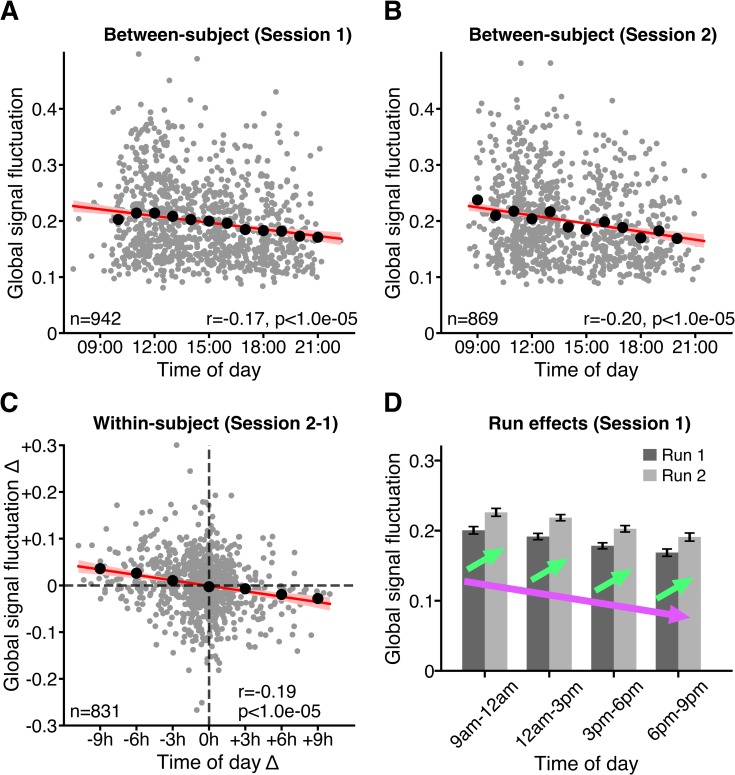
The brain’s GS fluctuation (standard deviation of GS) decreases with time of day.(A) Between-participant variation in GS fluctuation as a function of time of day in session 1. (B) Between-participant variation in GS fluctuation as a function of time of day in session 2. (C) Within-participant variation in GS fluctuation Δ as a function of time of day Δ, where Δ denotes difference between session 2 and session 1. Grey dots denote individual participants. Black dots show mean of GS fluctuation in (A, B) hourly or (C) 3-hourly time windows. Line of best fit (red) was calculated based on data from all participants in each plot. Confidence interval is shown in light red. R values denote Pearson r correlation coefficient. p-Values were derived from 100,000 permutations, while keeping family structure intact [40]. (D) GS fluctuation is elevated in run 2 compared with that in run 1 despite downward shift in GS fluctuation as a function of time of day. Bar plots denote mean GS fluctuation across participants within 3-hourly time windows for each run. Error bars denote standard error of the mean. Two opposing effects are observable: a fast increase in GS fluctuation on the scale of minutes—i.e., run effect (green arrows)—superimposed on a downward drift of GS fluctuation occurring on the scale of hours—i.e., time of day effect (violet arrow). See S1 Data for underlying data. GS, global signal.